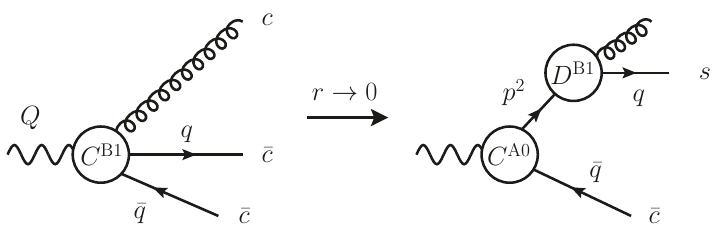
Figure 3 . Graphical representation of the factorization (4.1) of the B1 matching coefficient in the soft-quark